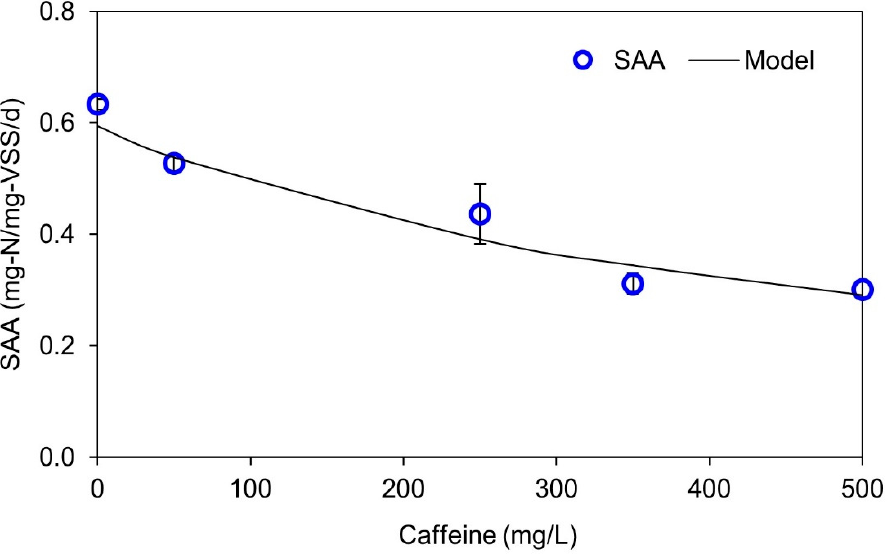
Figure 3. Specific anammox activity vs. caffeine concentration. The line represents the best fit of non- or an un-competitive model.